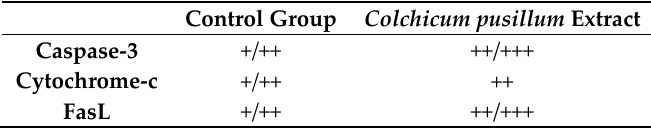
Table 1. The intensity of caspase-3, cytochrome-c and FasL immunolabelling in Colo-741 cells treated with Colchicum pusillum extract at 20 µg/mL concentration for 48 h.